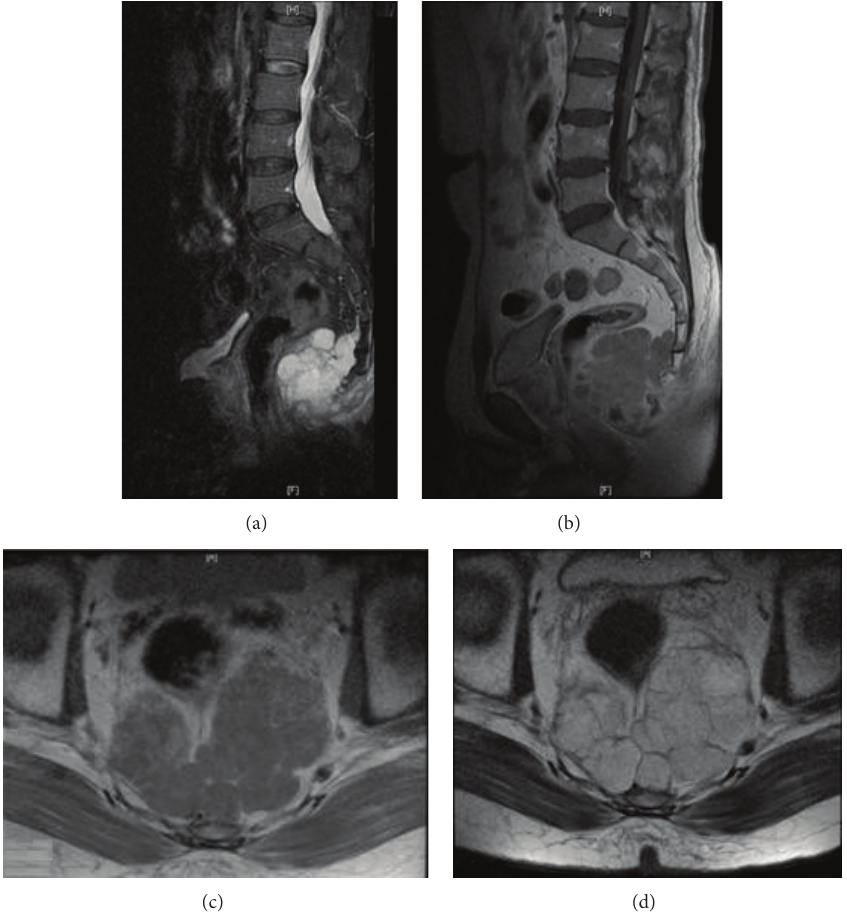
Figure 1: Preoperative sagittal and axial MRI of sacrococcygeal